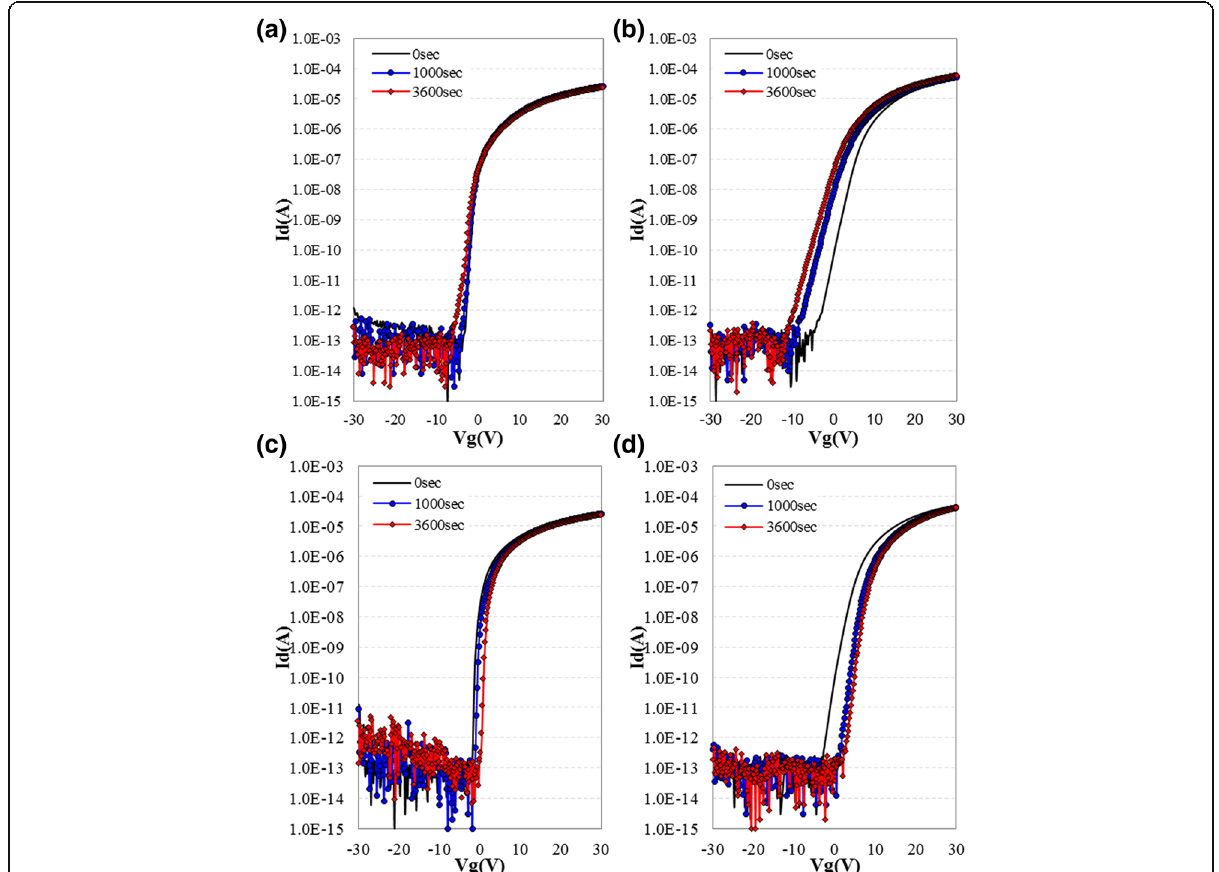
Fig. 6 (Color online) I-V transfer characteristic drift of CL-ES ( a , c ) and BCE ( b , d ) TFT obtained from NBITS ( a , b ) and PBTS testing ( c , d )